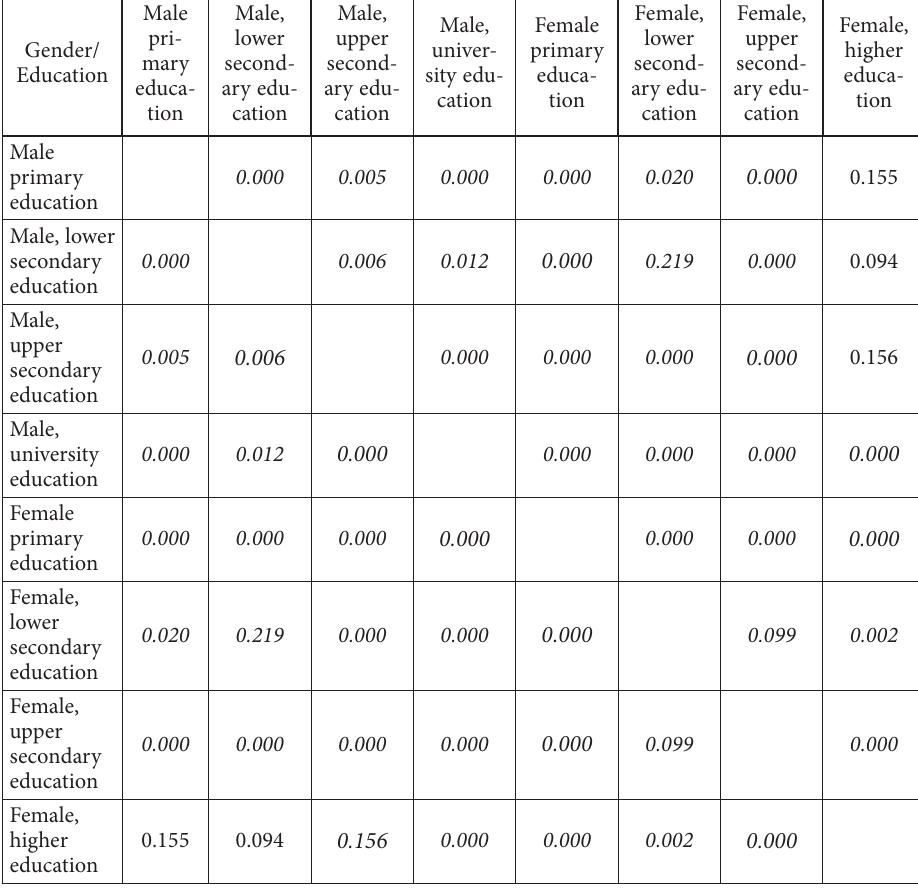
Table 16. Tukey’s HSD test results within motivational factors for job